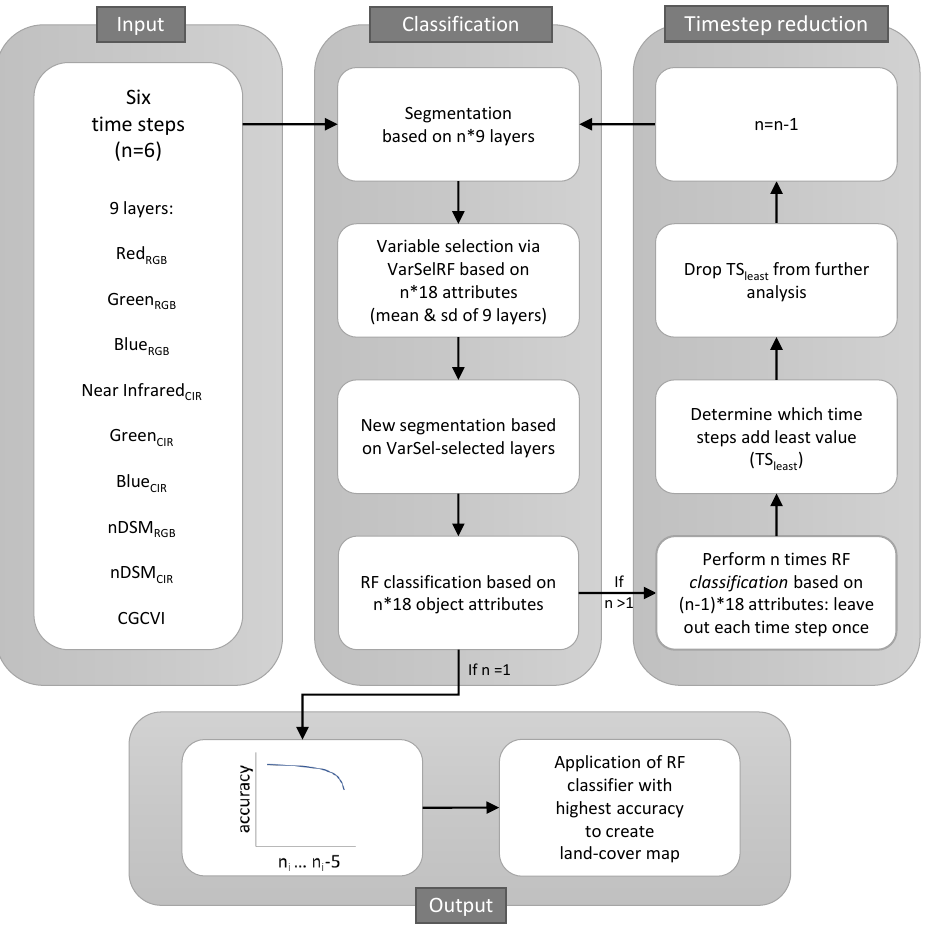
Figure 3. Workflow of multitemporal segmentation, classification, and validation, resulting in accuracy by decreasing the number of time steps. The subscript RGB indicates a true colour layer and CIR indicates a false colour. Random Forest (RF) and varSelRF are classification models in